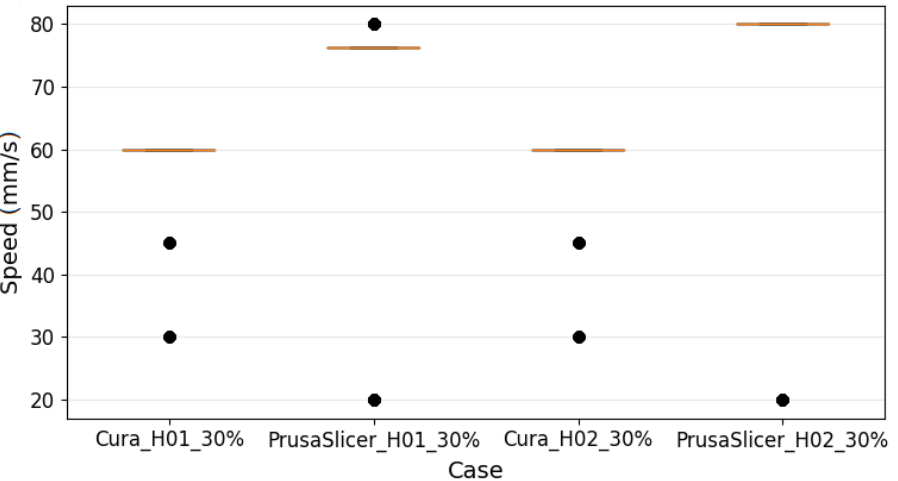
Figure 4. Speed of the print head identified for the option “fill” lines only. A significant reduction of the total number of lines can be observed for the Cura